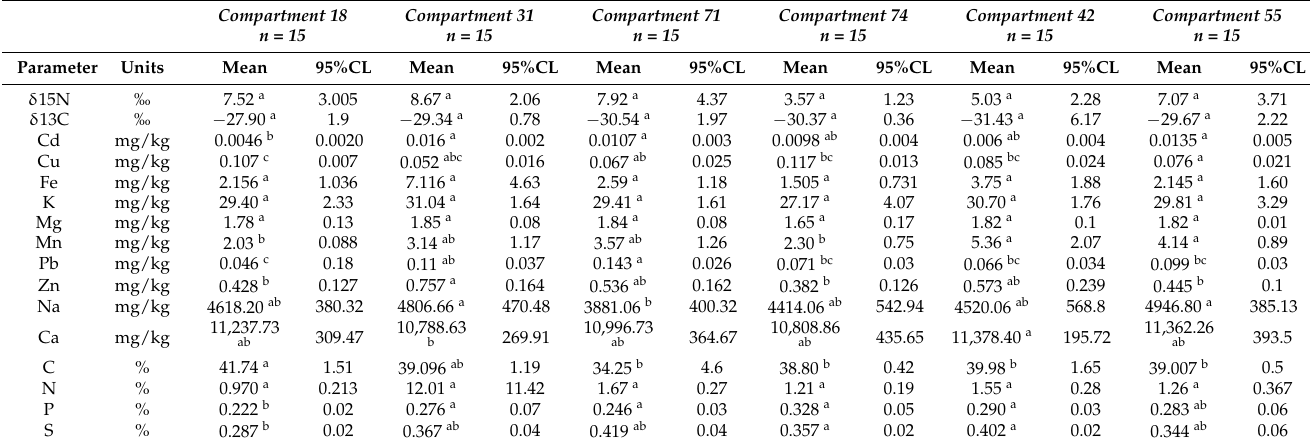
Table 1. The chemical composition of Rhizophora apiculata leaves in six compartments (18, 31, 71, 74, 42, and